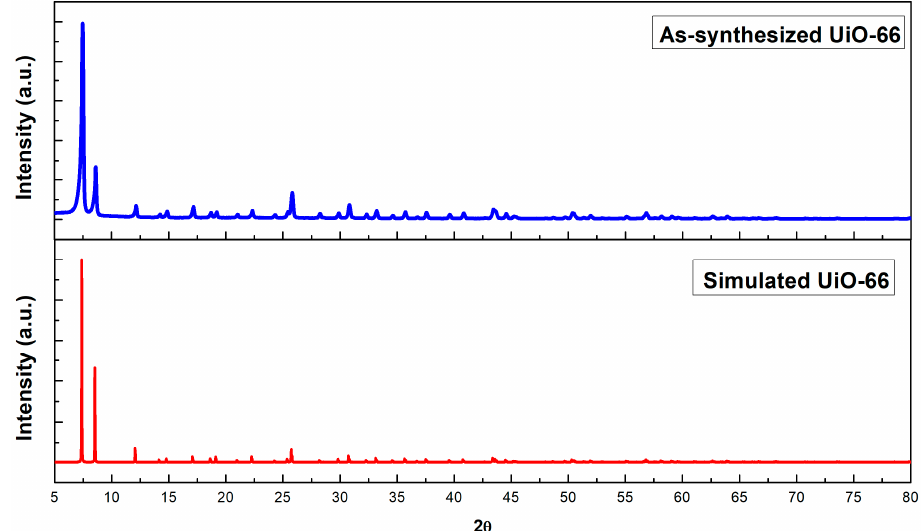
Molecules 2023 , 28 , x FOR PEER REVIEW Figure 1. The XRD patterns of as-synthesized UiO-66 and simulated UiO-66. Figure 1. The XRD patterns of as-synthesized UiO-66 and simulated UiO-66.